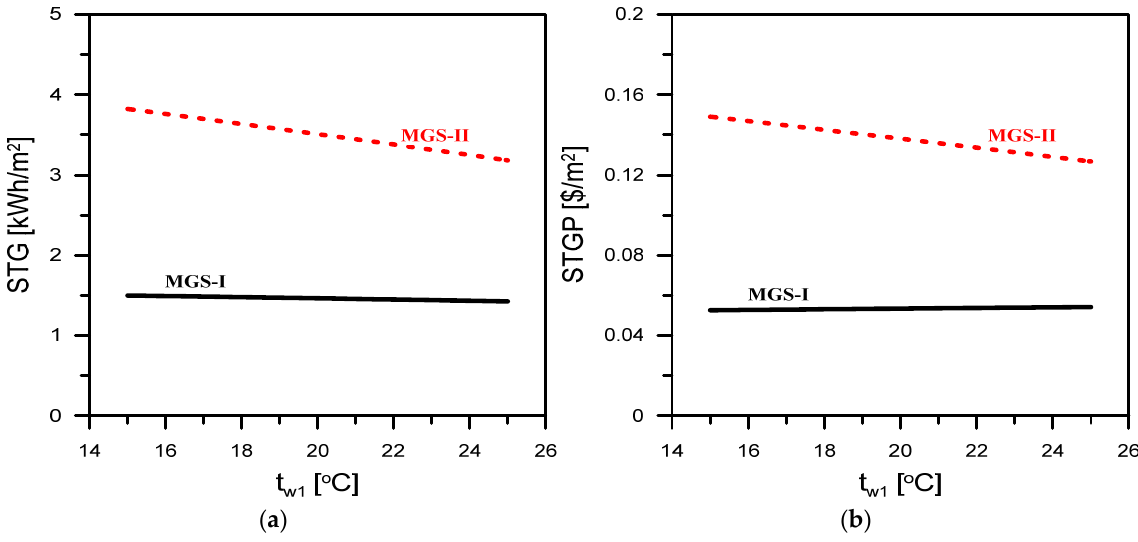
Figure 7. Impact of seawater inlet temperature on proposed systems’ performance: ( a ) STG; ( b ) STGP.